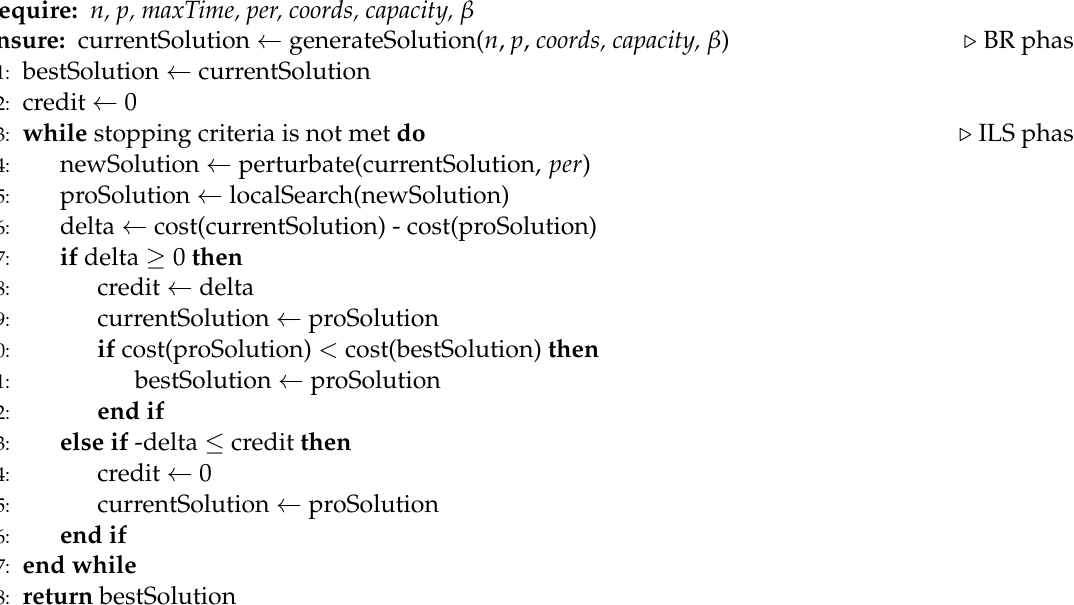
Algorithm 1 General Biased Randomized-Iterated Local Search (BR-ILS)